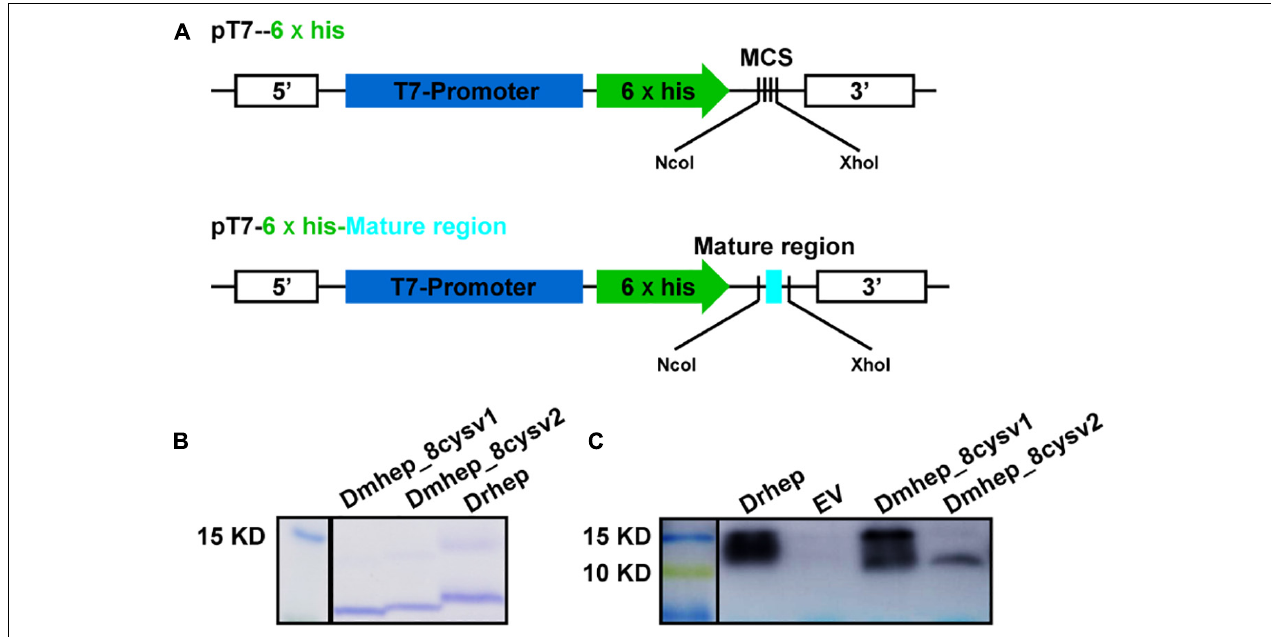
FIGURE 5 | Expression and purification of hepcidin in E. coli . (A) The structure of recombinant plasmid with or without mature region of hepcidin . (B) Purified hepcidin peptide detected by Coomassie blue staining. (C) Purified hepcidin peptide detected by Western blot.